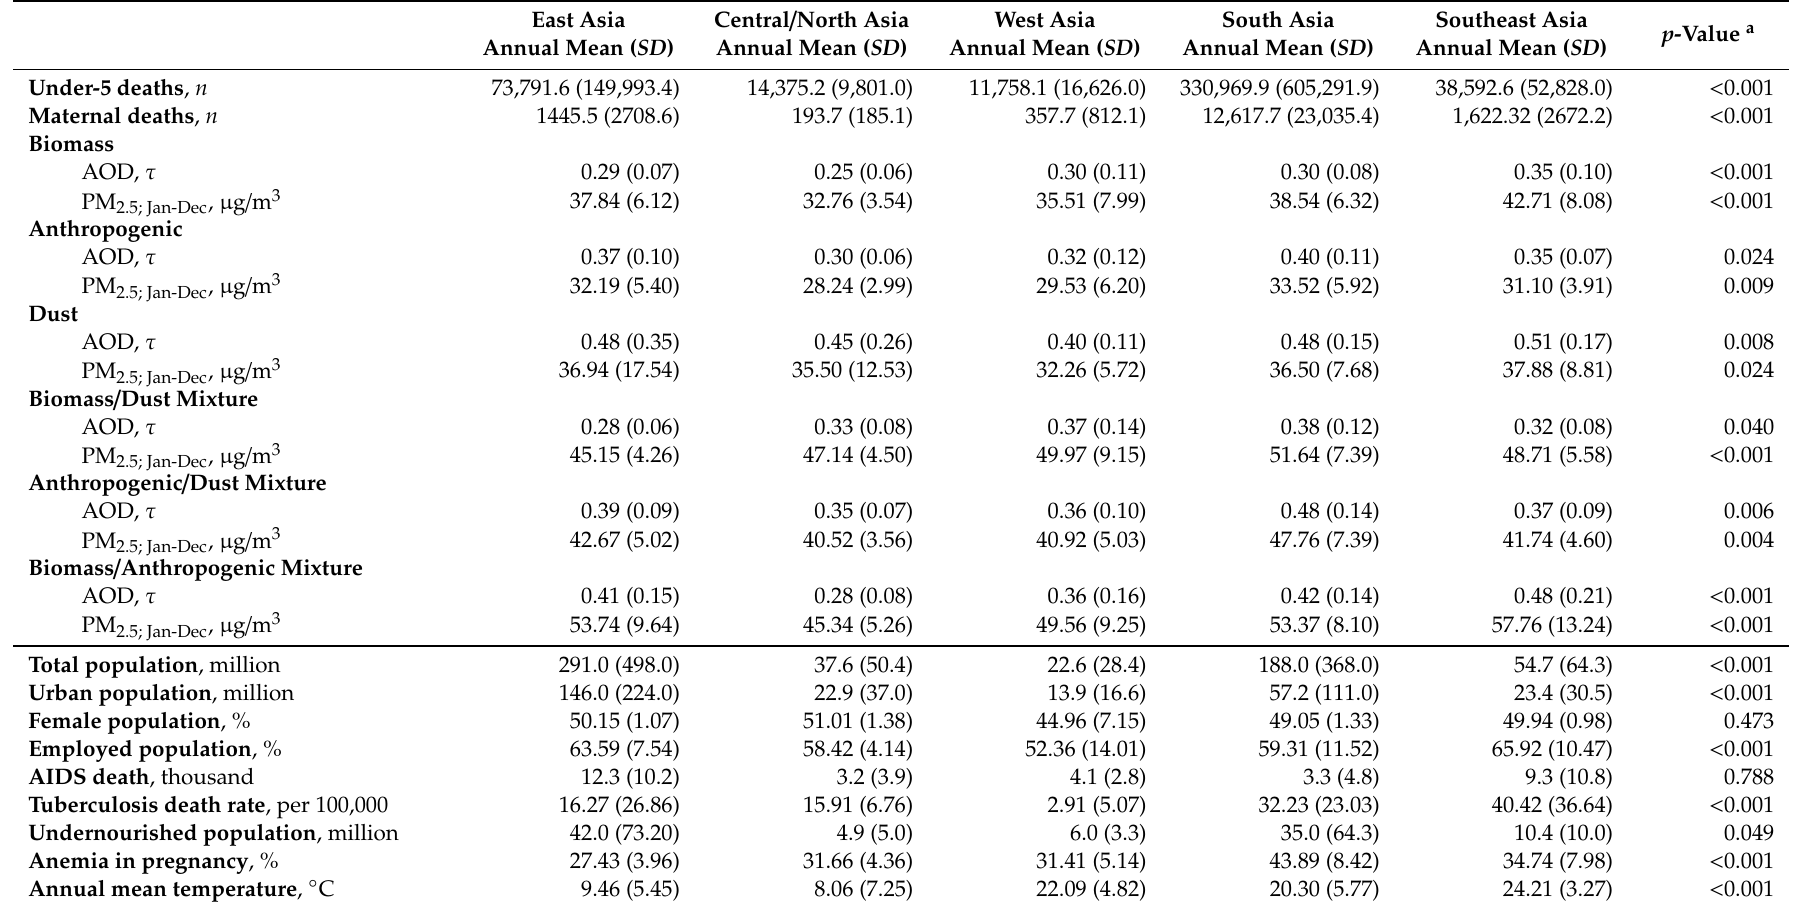
Table 1. Descriptive statistics of long-term under-five and maternal deaths, aerosol optical depth (AOD), types of PM 2.5 and population characteristics, by sub-regions of